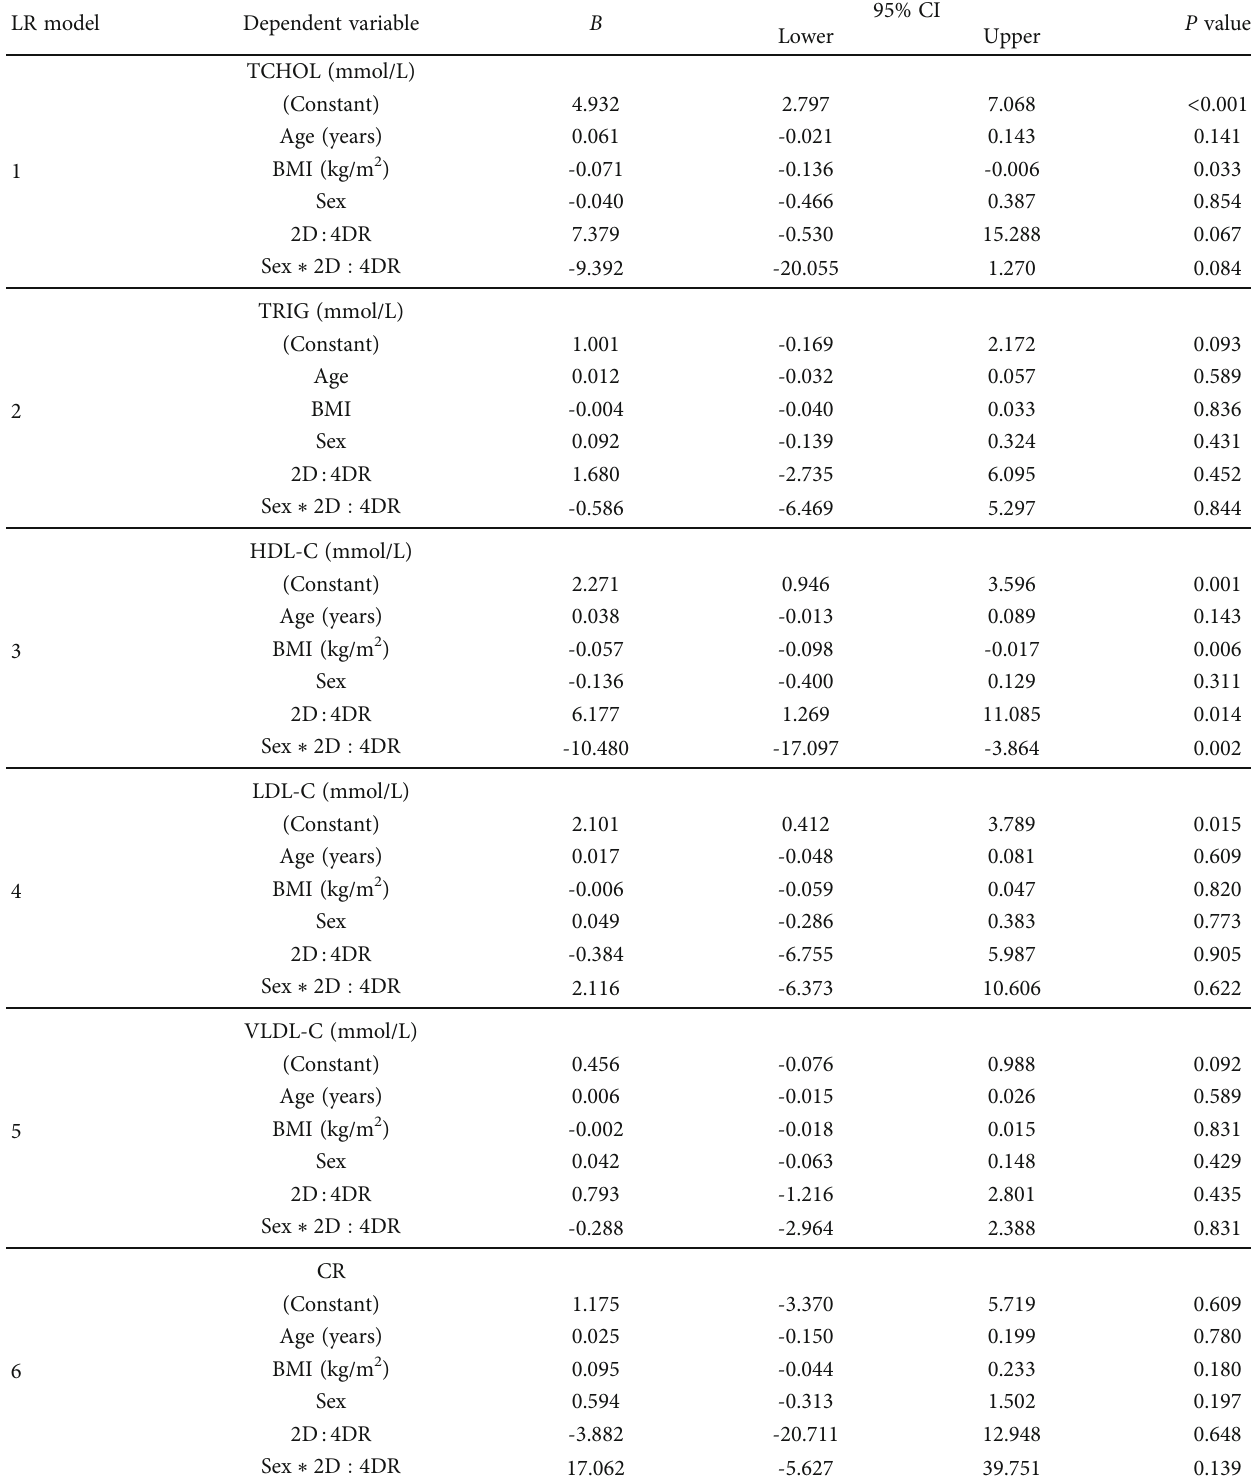
Table 2: Interactions between sex and the 2D:4DR on fasting plasma lipid